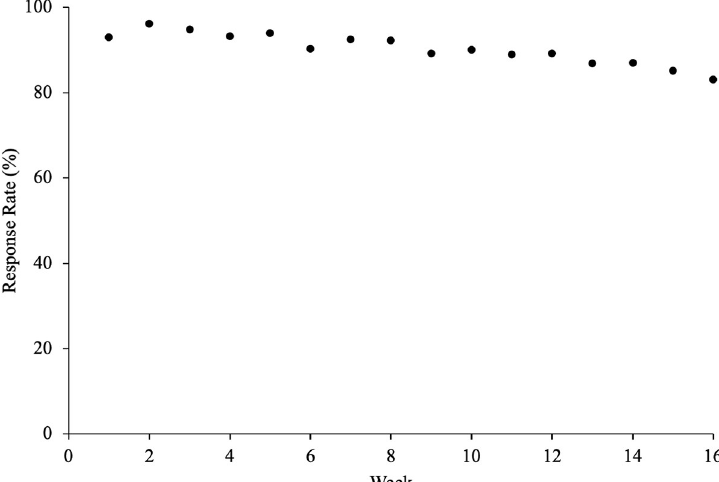
Fig 3. Survey response rate as a function of week. Eighteen participants who had a response rate less than 35% are included.